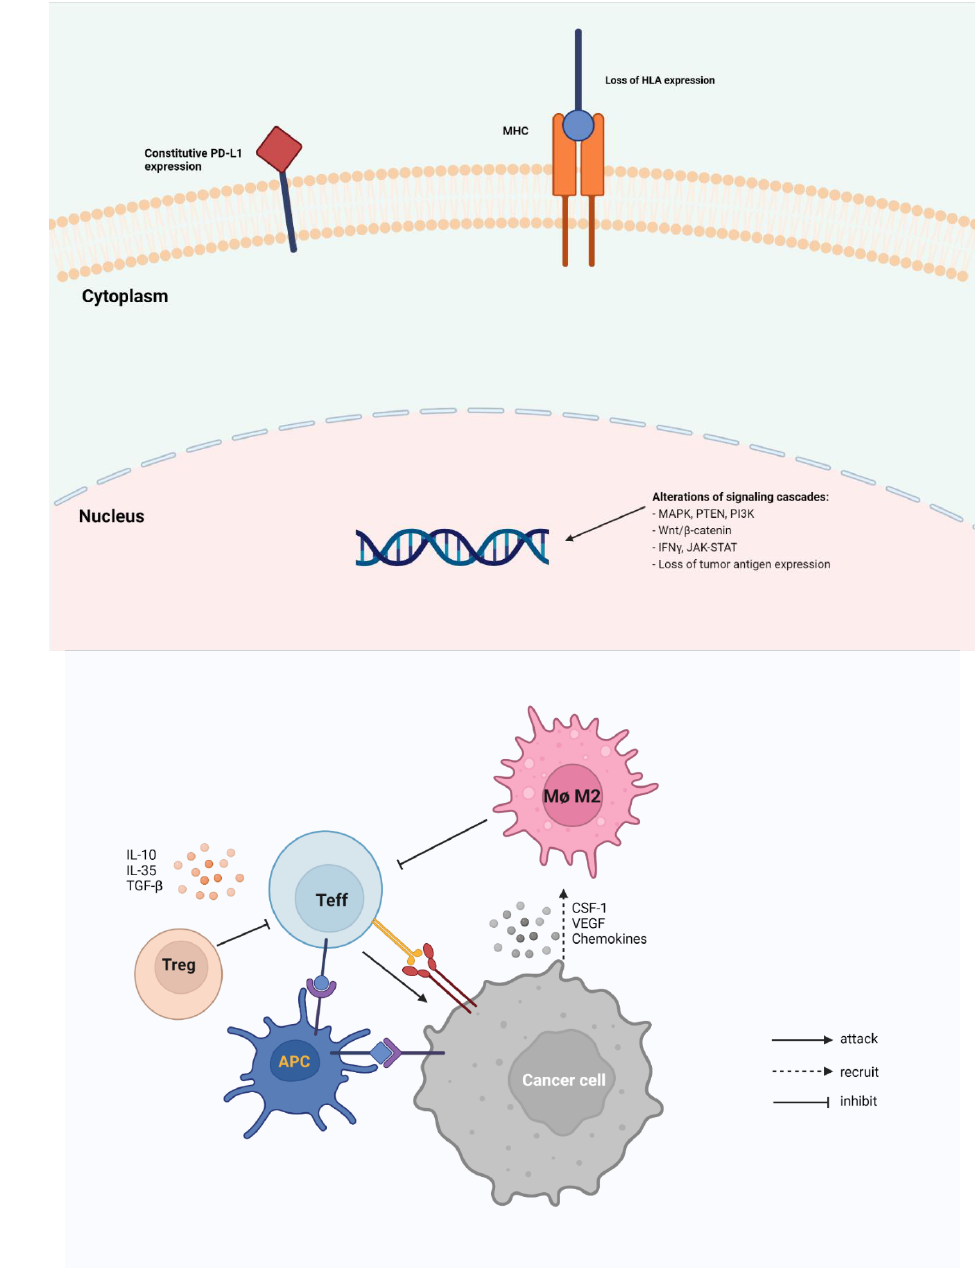
Figure 1. Tumor-intrinsic and -extrinsic mechanisms of resistance to immunotherapy. ( A ), a general diagram of how cancer resistance emerges upon immunotherapeutic treatment. Intrinsic mutation in tumor cells renders cancer cells primary resistance upon immunotherapy leading to refractory tumor. Acquired resistance is generated in survived cancer cells upon immunotherapy leading to refractory tumor. ( B ), tumor-intrinsic mechanisms of resistance. Intrinsic factors include constitutive PD-L1 expression, loss of HLA expression in cancer cell membrane, and alterations of signaling cascades such as MAPK, PTEN, PI3K, Wnt/ β -catenin, IFN γ , JAK-STAT, and loss of tumor antigen expression. ( C ), tumor-extrinsic mechanisms of resistance. The complex interplay of immune cells and cancer cells in tumor-microenvironment. Cancer cells are constantly subjected to bombardment by immune cells such as NKs and Teffs. However, cancer cells produce CSF-1, VEGF, and several chemokines to recruit M2 macrophages which in turn inhibit Teffs. Treg also induce cytokines, such as IL-10, IL-35, TGF- β to impede Teff